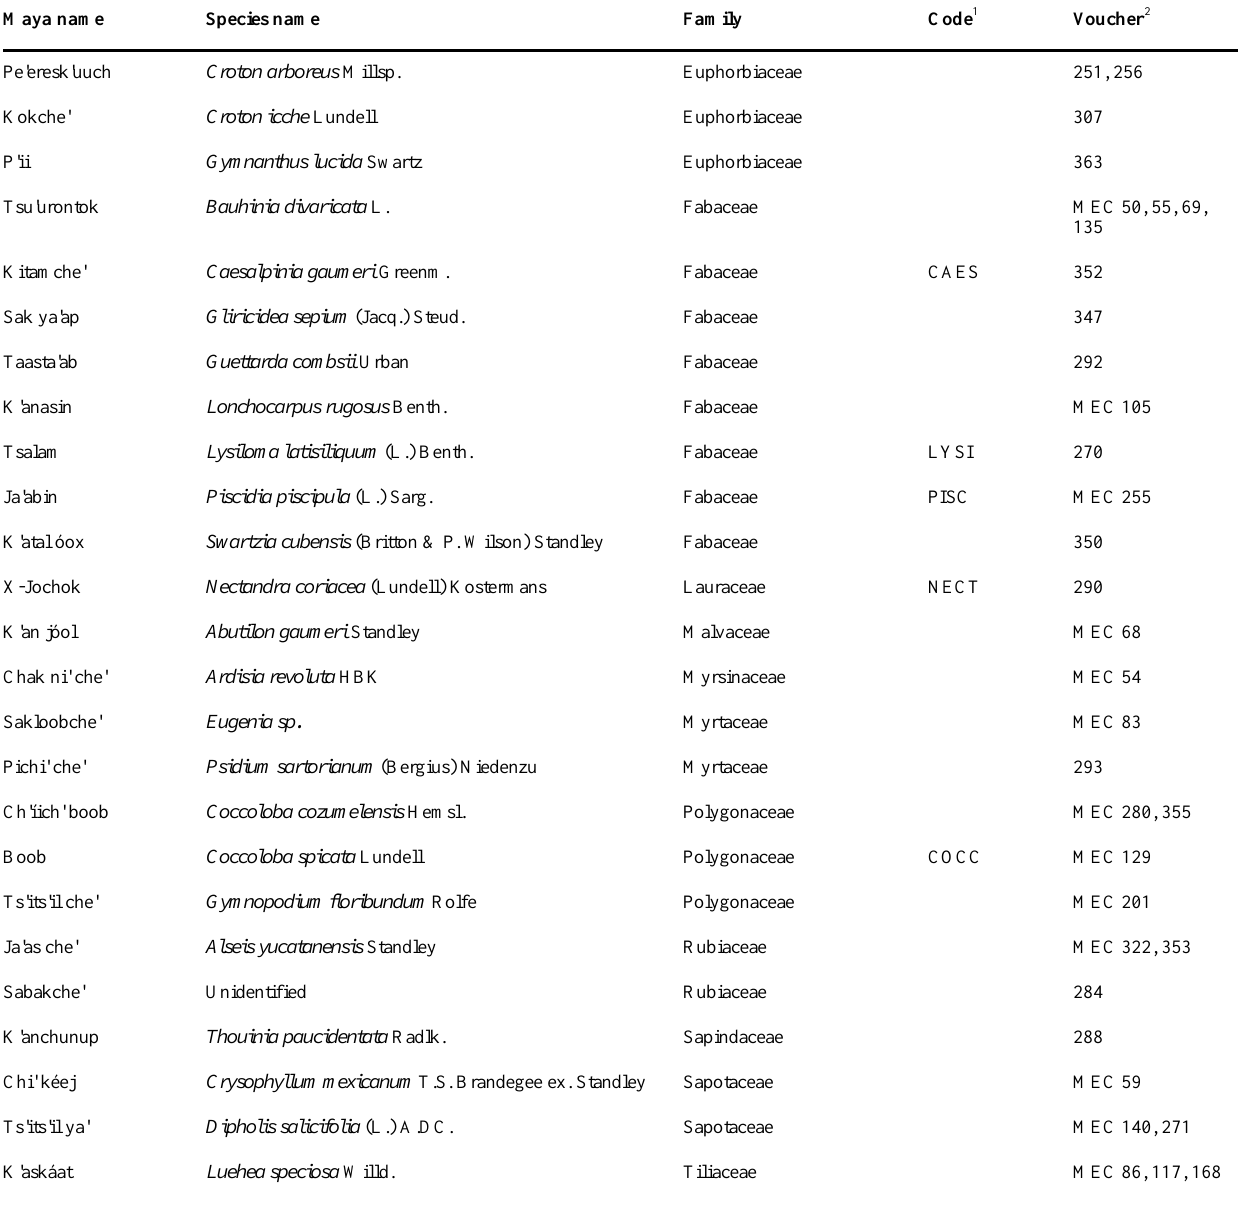
1 Code: first four letters of the genus name. Used in figures to indicate firewood species whose regeneration in the milpas was measured.